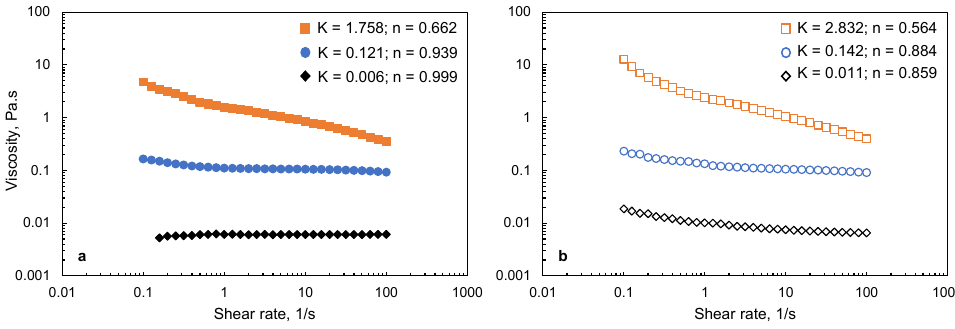
Figure 1. Apparent viscosity of ( a ) MC film-forming solutions ( ♦ ) M20; ( ● ) A4C; ( ■ ) A4M; and ( b ) MC-SNC film-forming solutions ( ◊ ) M20-15% SNC; ( ○ ) A4C-15% SNC; ( □ ) A4M-15% SNC.